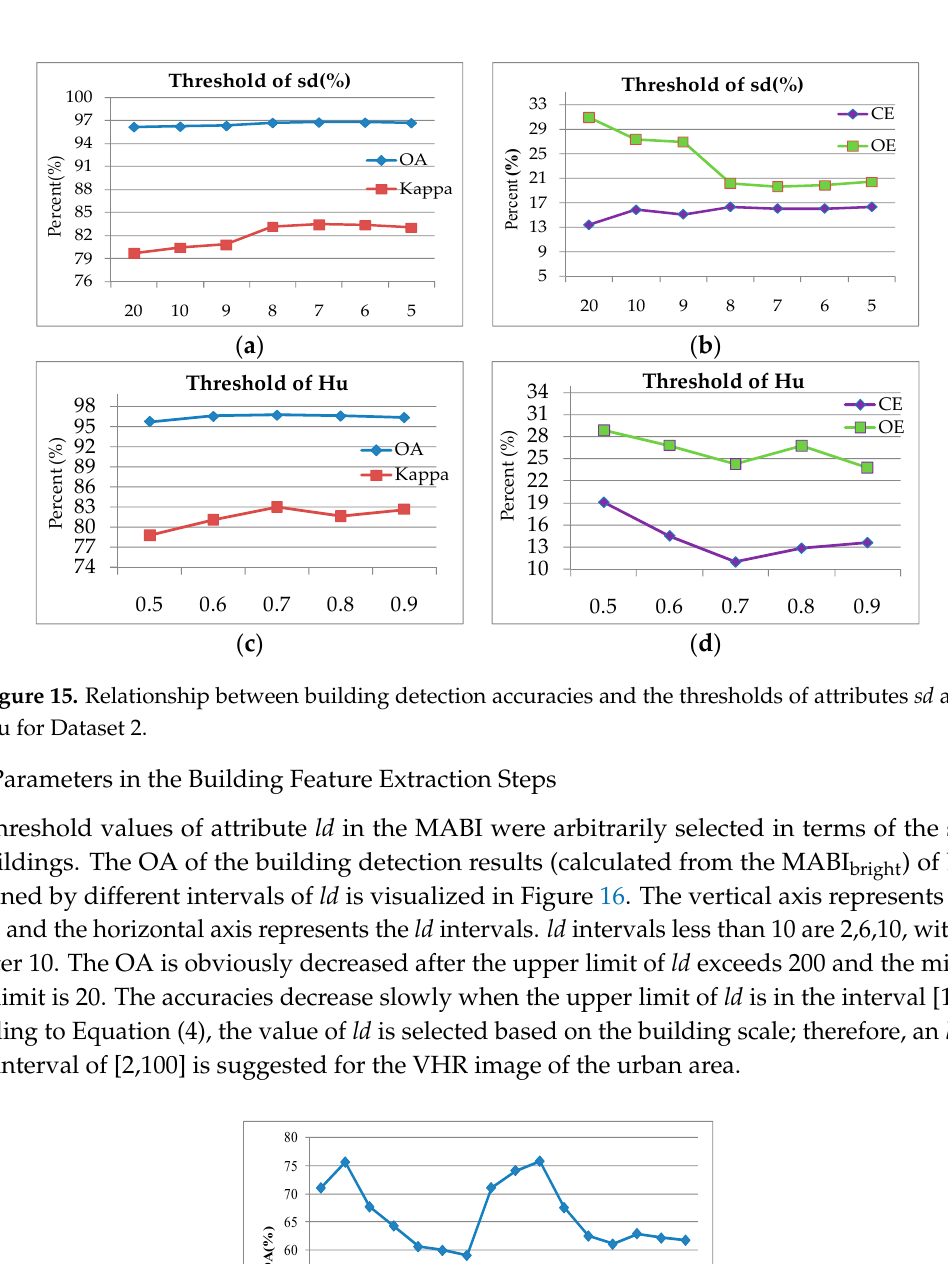
Figure 15. Relationship between building detection accuracies and the thresholds of attributes sd and Hu for Dataset 2. Figure 16. Relationship between overall accuracies of building detection and the thresholds of attribute ld in Dataset 2.